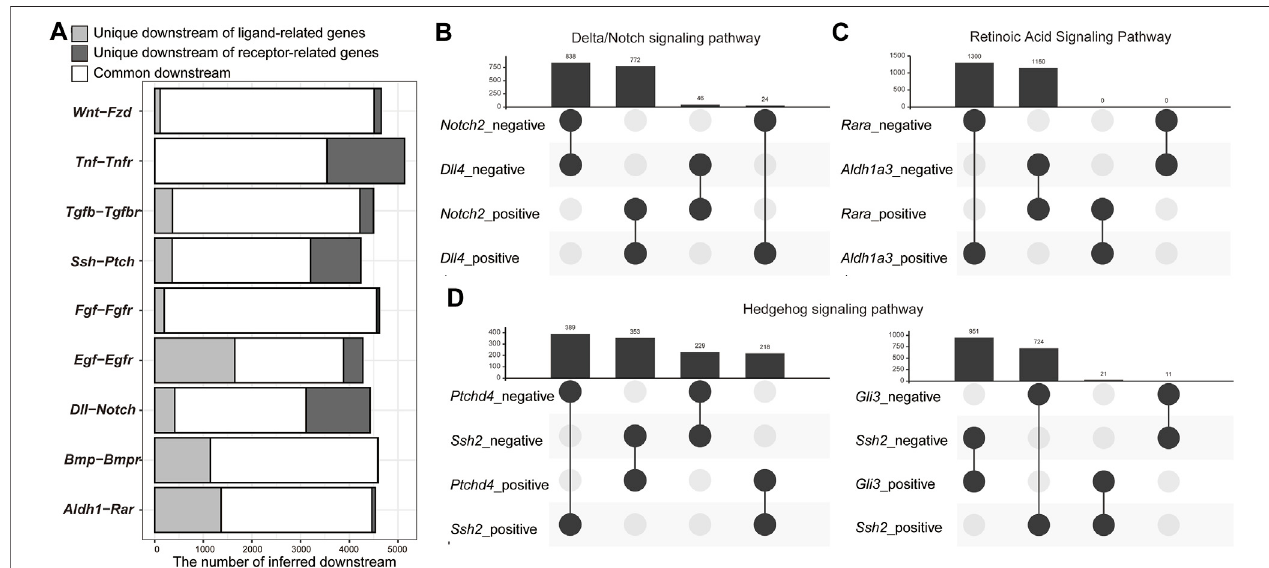
FIGURE 4 | Overlap of inferred genes downstream of ligand- and receptor-related genes. (A) Bar plot of the number of inferred downstream genes that are common and unique for each ligand-receptor pair. (B – D) Upset plots of inferred downstream genes that are positively and negatively regulated by the representative ligand- and receptor-related genes. (B) Retinoic acid signaling pathway. (C) Delta/Notch signaling pathway. (D) Hedgehog signaling